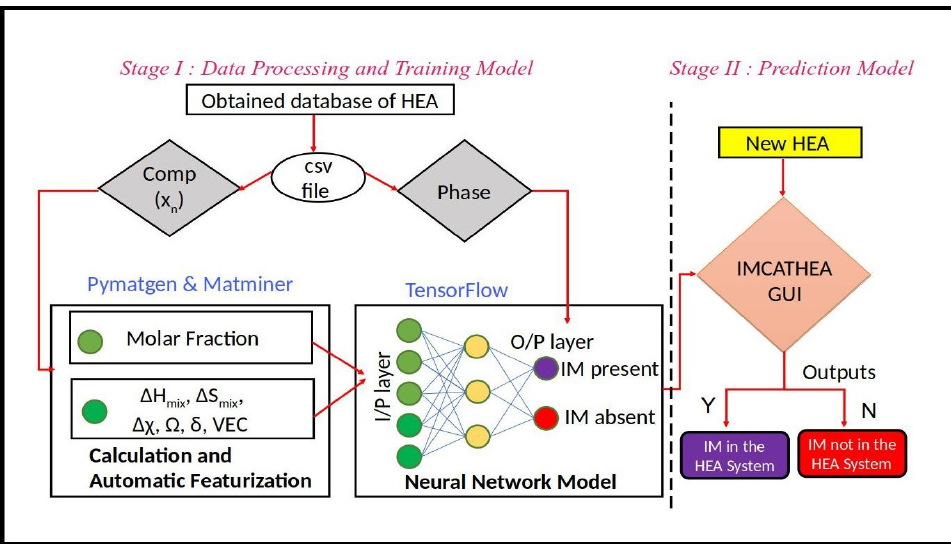
Figure 1. The construction of the digital toolkit for the prediction of the presence of an intermetallic (IMC or IM) phase in a given HEA system is complete within the two stages. Stage I involves data preprocessing and training of the neural network, and the subsequent stage II incorporates the deployment of a GUI interface built upon the prediction model. The capabilities of Pymatgen and Matminer libraries are utilized to establish the numerical fingerprints associated with the input composition features. These composition features are then utilized by the python code to compute the property features. Literally, the calculation and featurization task in stage I is enriched with automatic featurization